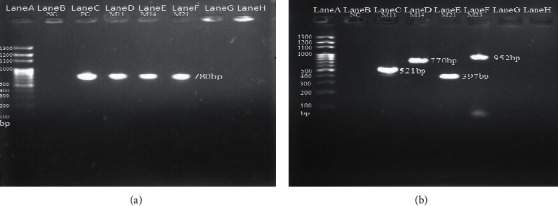
Photograph showing the results of gel electrophoresis from (a) the confirmatory PCR assay targeting 780 bp atr gene (lane A: 100 bp DNA size marker; lane B: negative control (NC); lane C: positive control (PC); lanes D to F: clinical GBS samples M11, M14, and M21) and (b) the multiplex PCR assay for genotyping of GBS (see the text for amplicons size-serotype correlations).